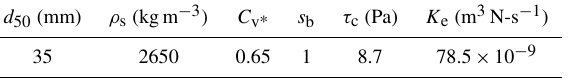
Table 3. Soil properties for debris flow simulation.